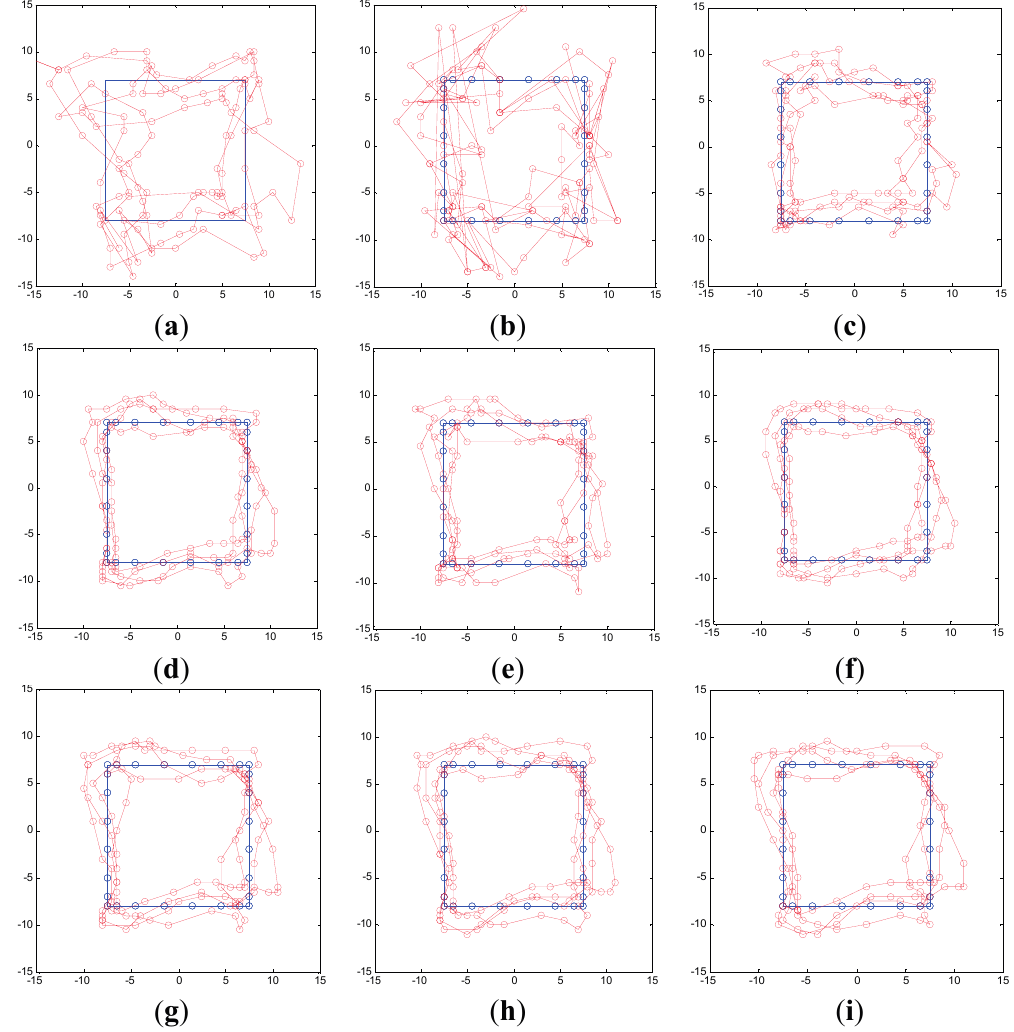
Figure 18. Simulation trajectories of different algorithms. ( a ) EKF; ( b ) ML; ( c ) D/TA; ( d ) I-D/TA;